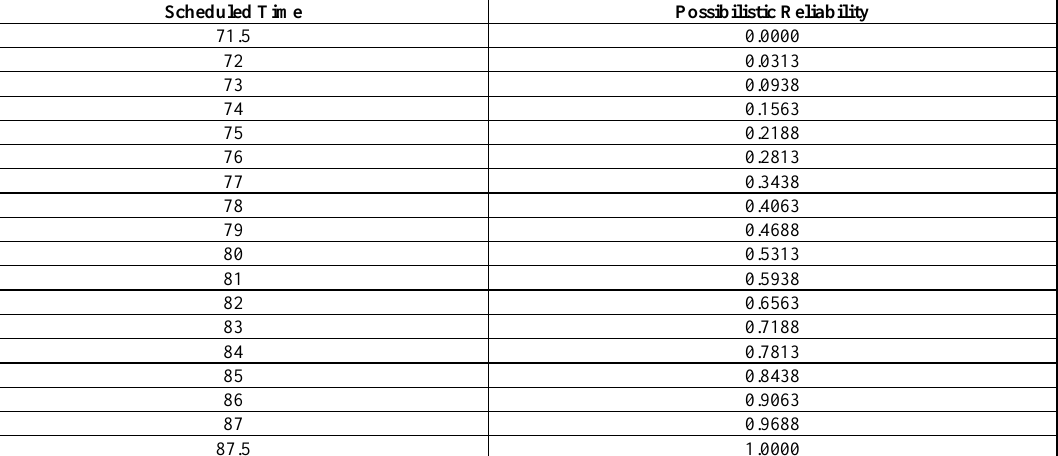
Table 3. Possibilistic reliability values (First